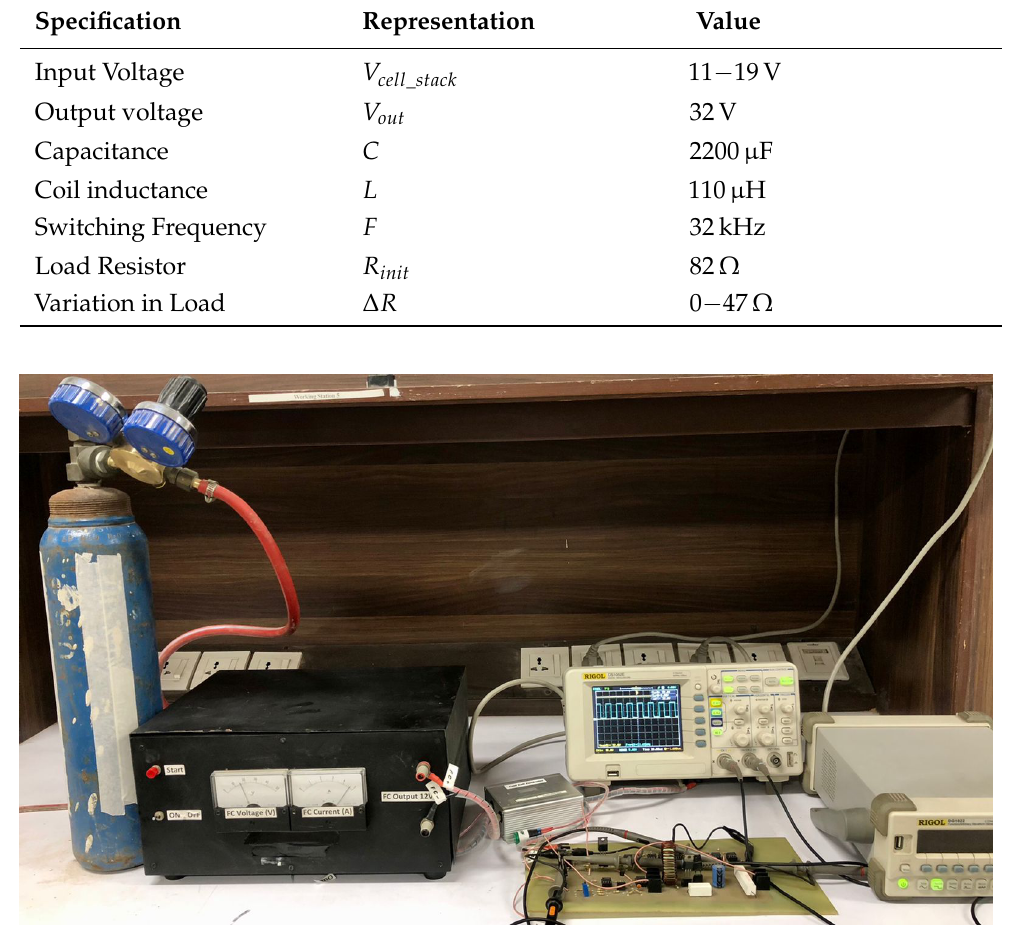
Table 3. Boost Converter Specification.